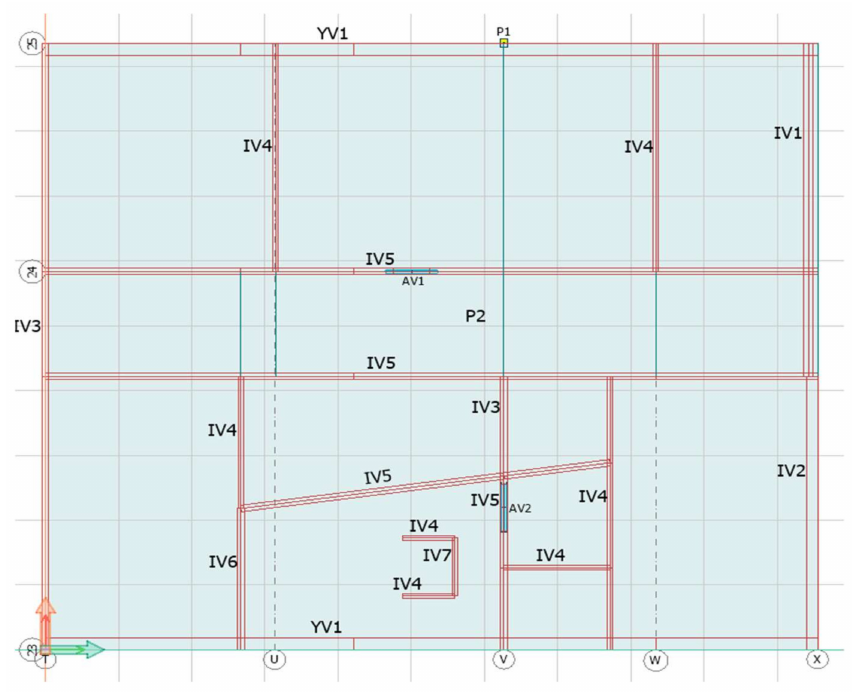
Figure 7. Floor plan of story 1 with named load-bearing